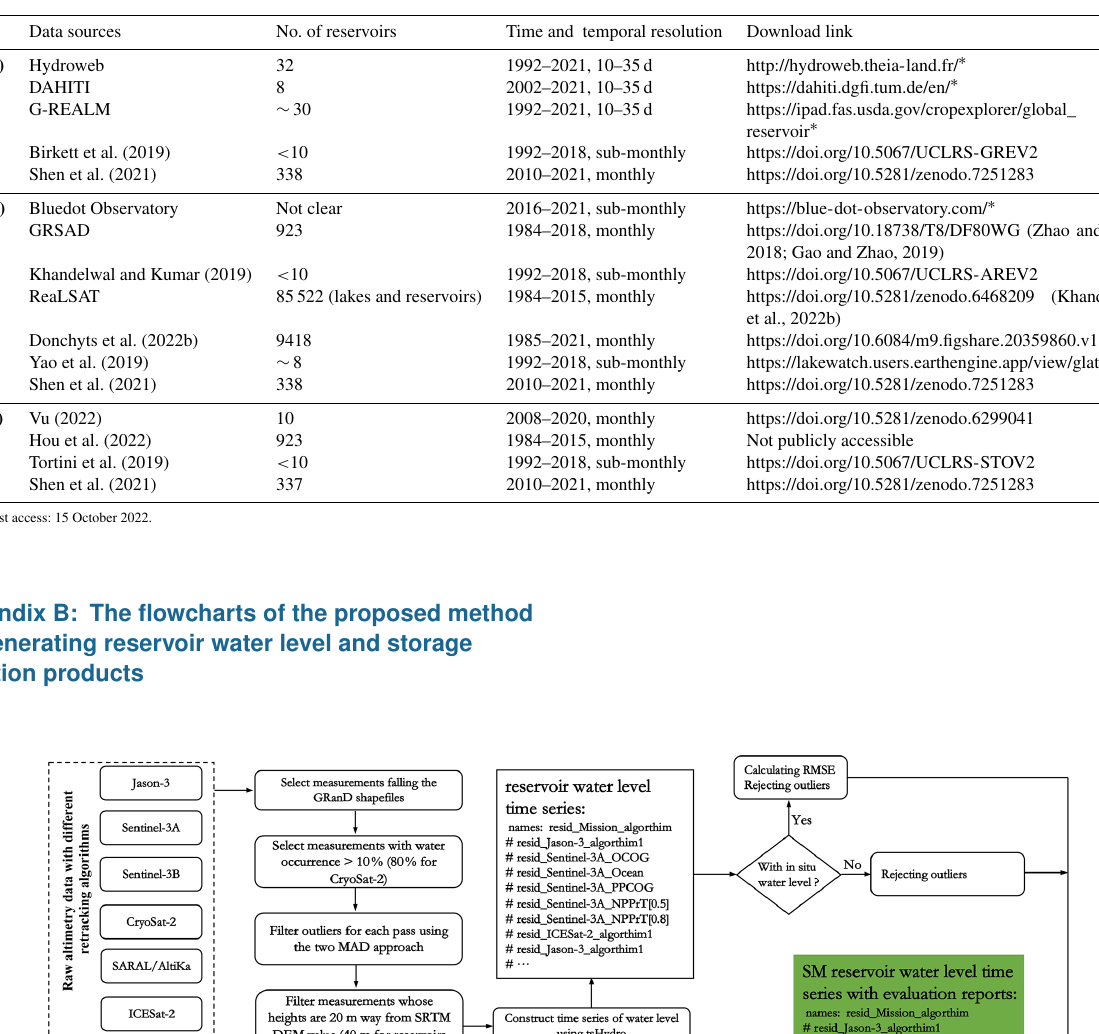
Table A1. Providers of water level (a) , area (b) , and storage variation (c) time series for Chinese reservoirs.